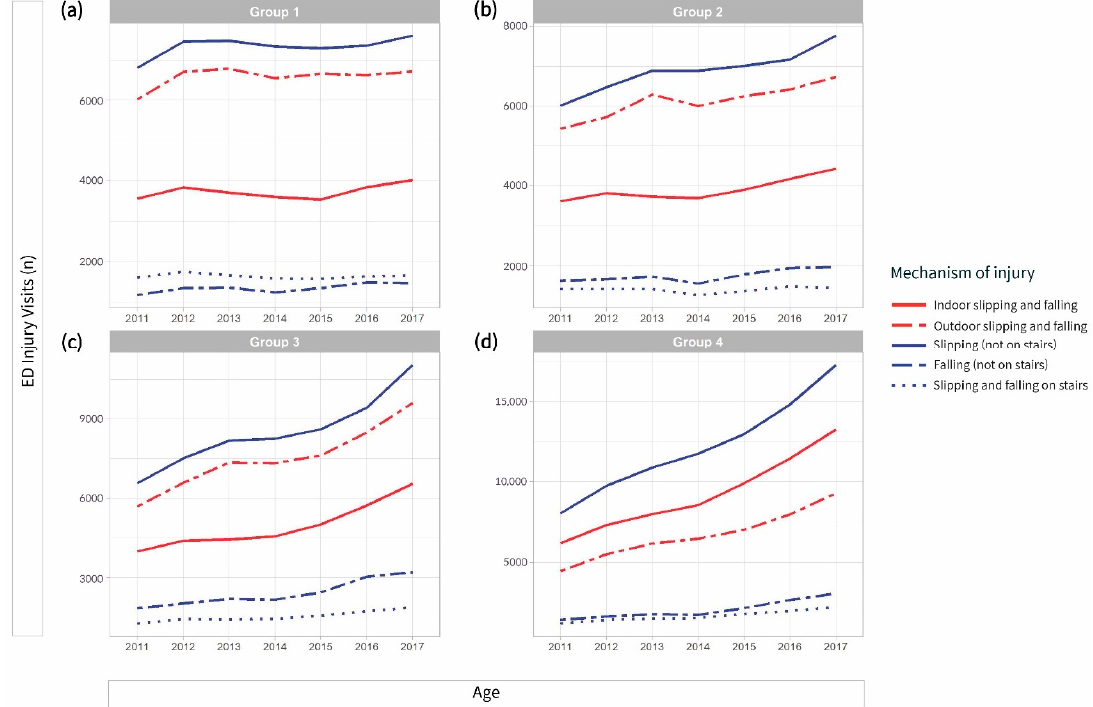
Figure 4. Subgroup analysis of slipping and falling in the injury mechanism by age group. ( a ) Group 1 (18–34 years old), ( b ) Group 2 (35–49 years old), ( c ) Group 3 (50–64 years old), ( d ) Group 4 ( ≥ 65 years). The red line indicates a subgroup that was divided into indoor and outdoor. The blue line indicates another subgroup divided into slipping and falling, which did not occur on stairs or occurred on stairs.